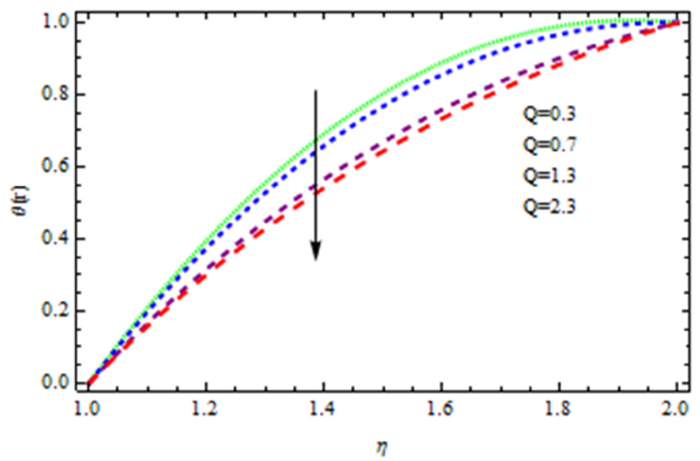
Figure 14. Influence of Q on the temperature curve.